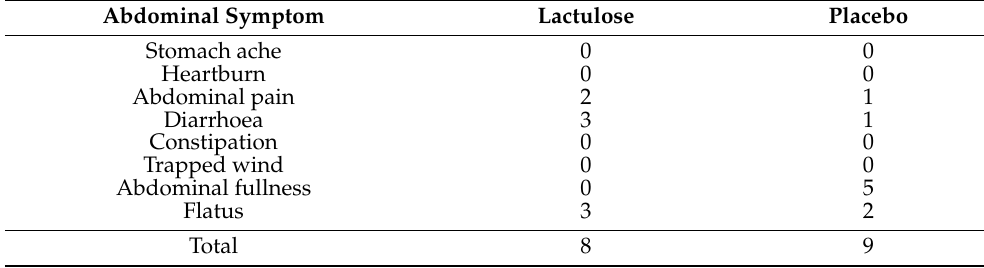
Table 6. Adverse events: principal secondary abdominal symptoms 1 .